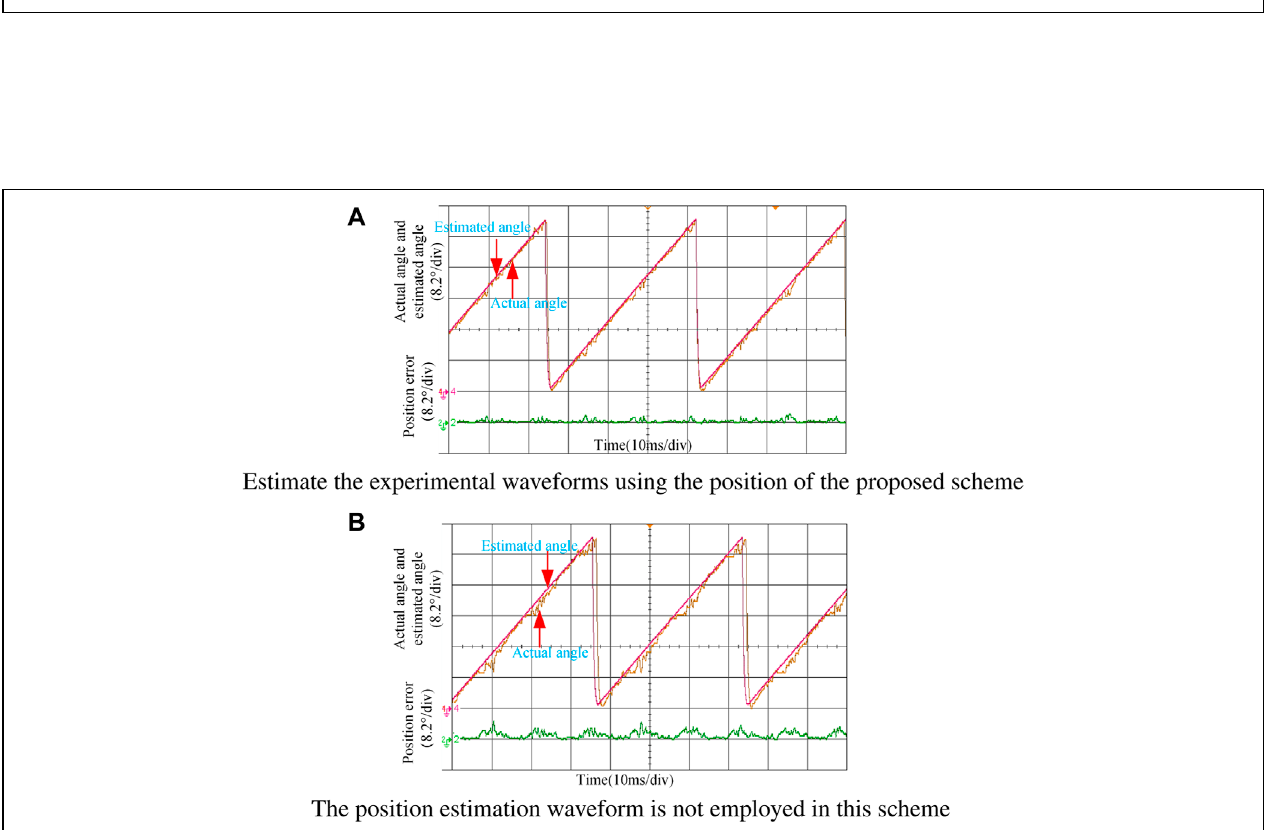
FIGURE 13 | Experimental waveforms of rotor position estimation with heavy load. (A) Estimation of the experimental waveforms using the position of the proposed scheme. (B) Position estimation waveform is not used in this scheme